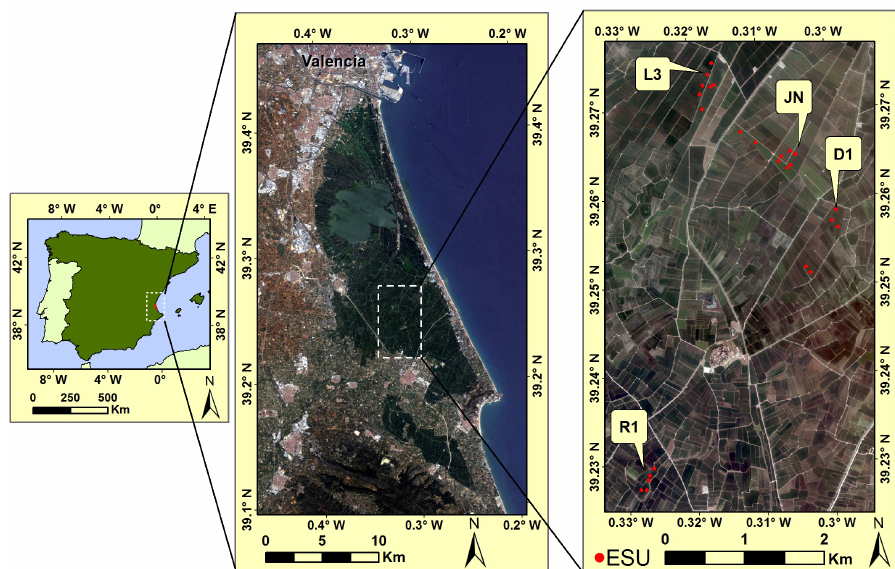
Figure 1. Study area: Location of the study area in Spain ( left ), a Landsat 8 Operational Land Imager (OLI) RGB composite image showing the extent of the rice fields ( middle ), and specific locations of the elementary sampling units (ESUs) within the rice fields ( right ). Four representative ESUs (R1, L3, JN, and D1) were selected for showing phenology